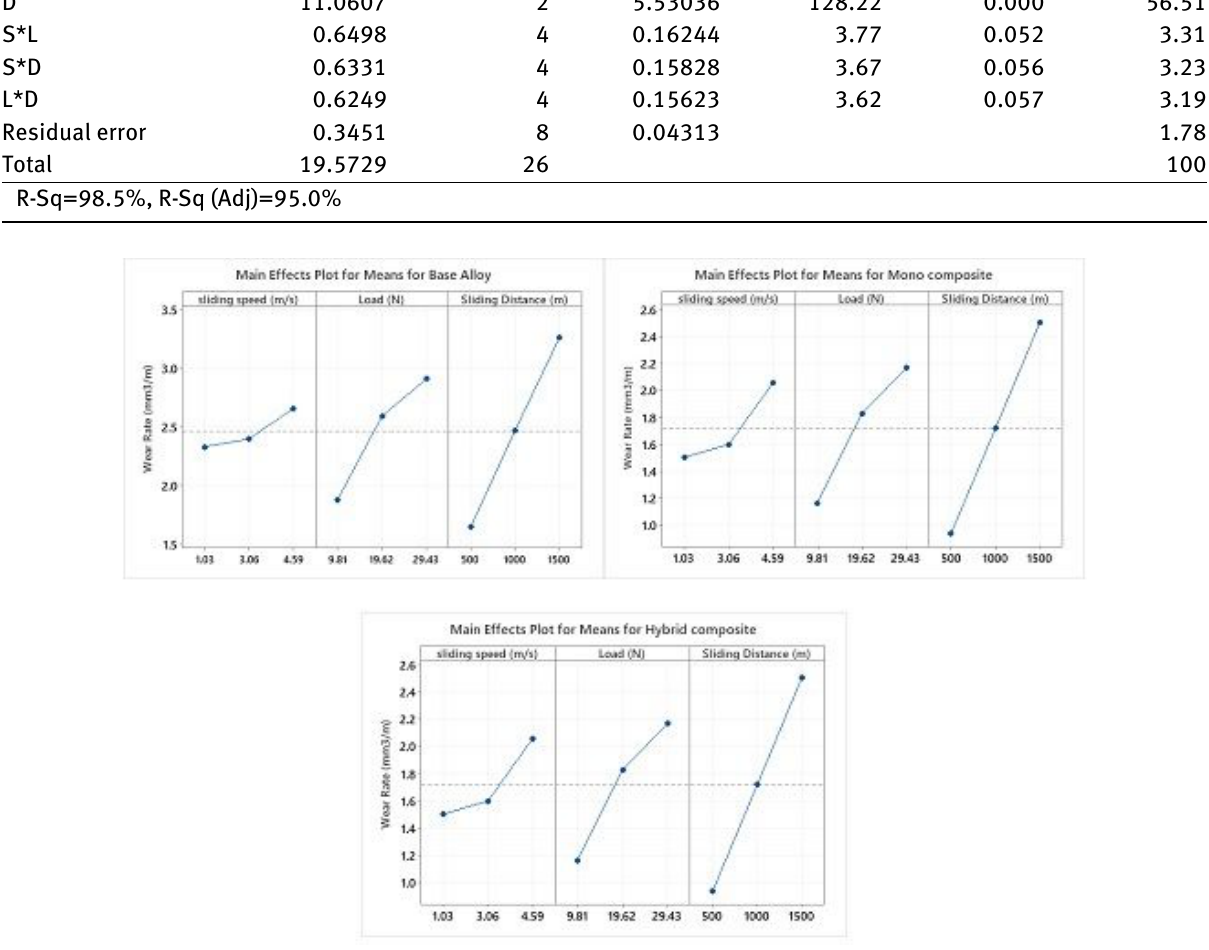
Figure 4: Main effects plots for wear rate of (a) base alloy; (b) mono composite; (c) hybrid composite